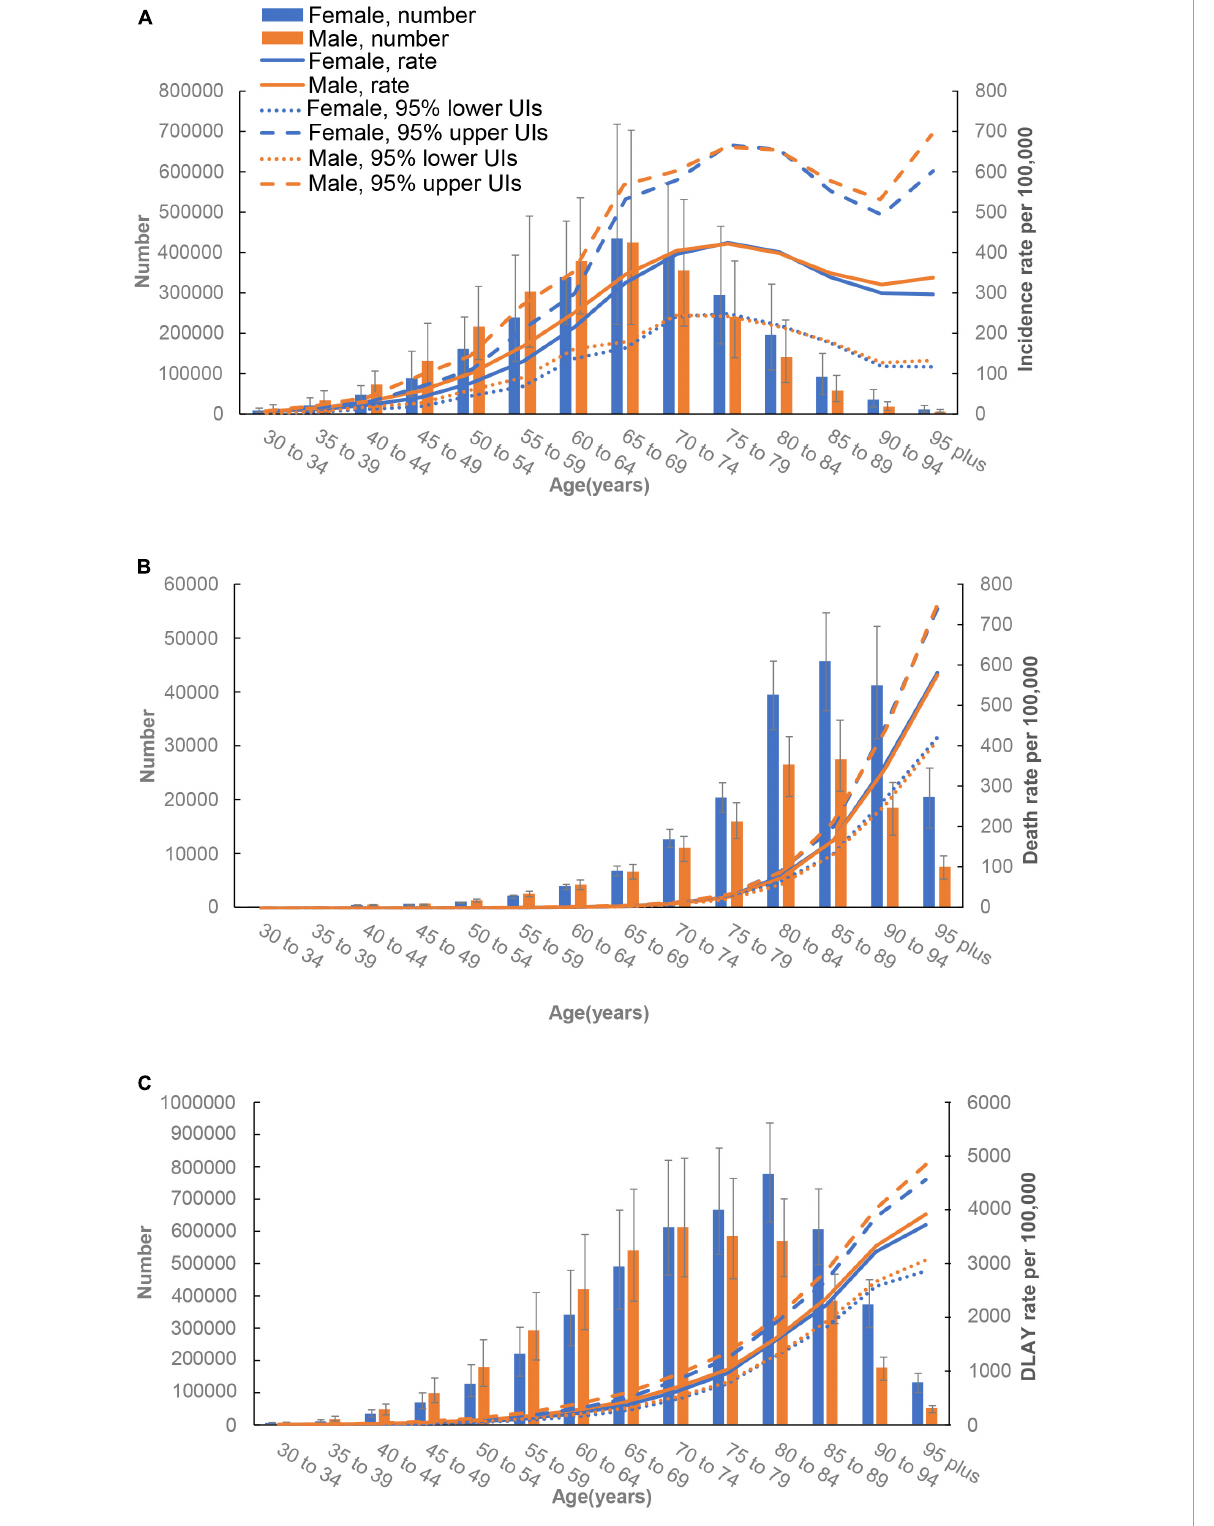
FIGURE4 Age-specific numbers and rates of incident cases (A) , death cases (B) , and disability-adjusted life-years (DALYs) (C) of atrial fibrillation by sex,